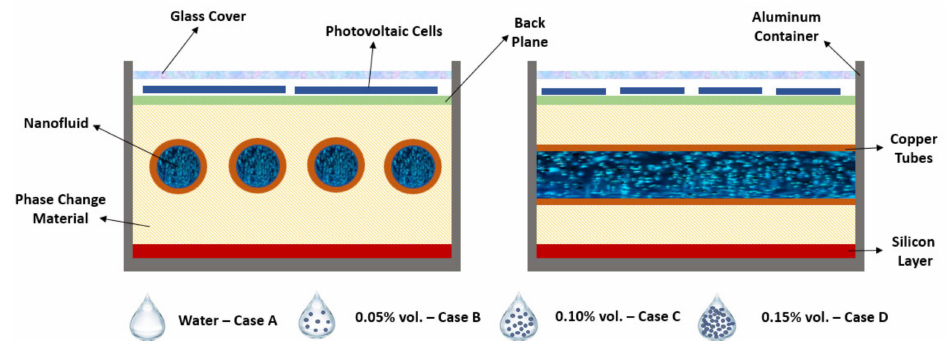
Figure 15. Schematic diagram of the configuration of the PV/T system for four different conditions. Adapted from